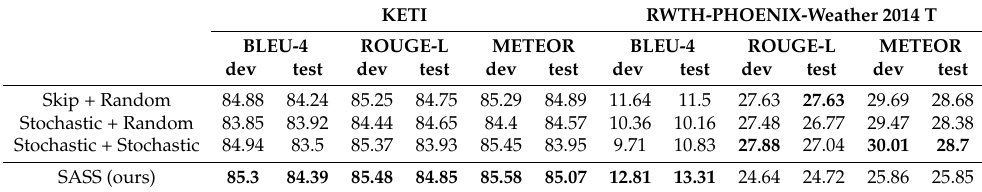
Table 4. Comparison of combinations of sampling and augmentation.